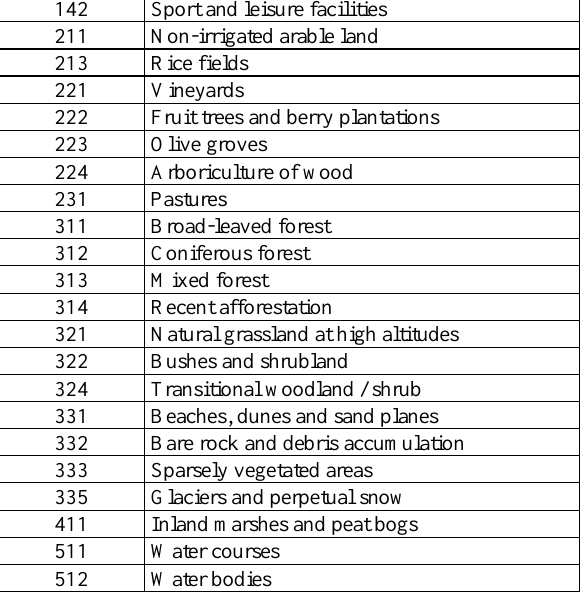
Table 2. Third level of DUSAF classification legend